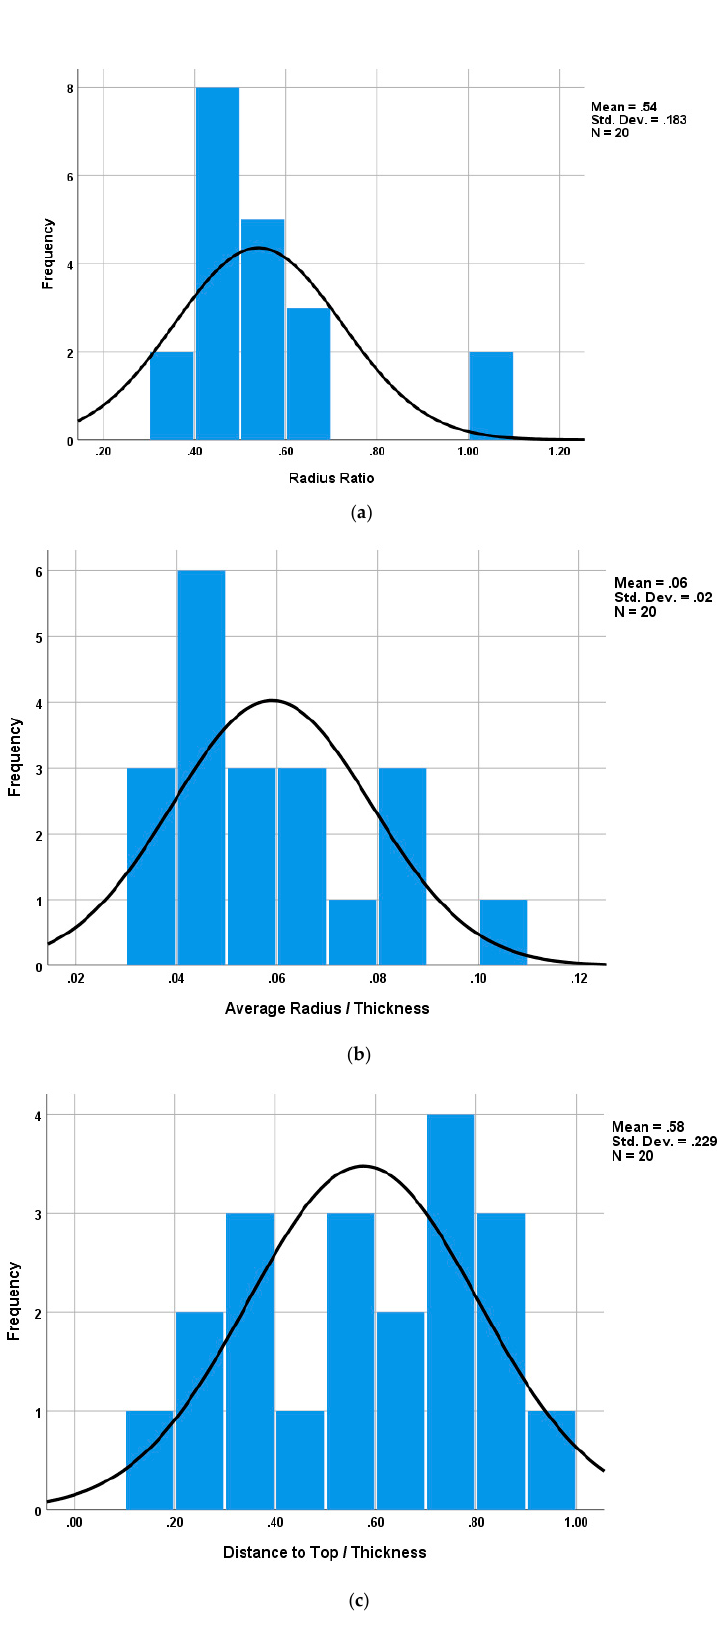
Figure 8. Statistical characteristics of microchannels of a coconut shell with a thickness of 2.88 mm (dimensions of the coconut shell specimen in x, y, and z: 18.6 mm, 18.98 mm, and 18.9 mm). ( a ) Radius ratio; ( b ) Average radius/thickness; ( c ) Distance to top/thickness.